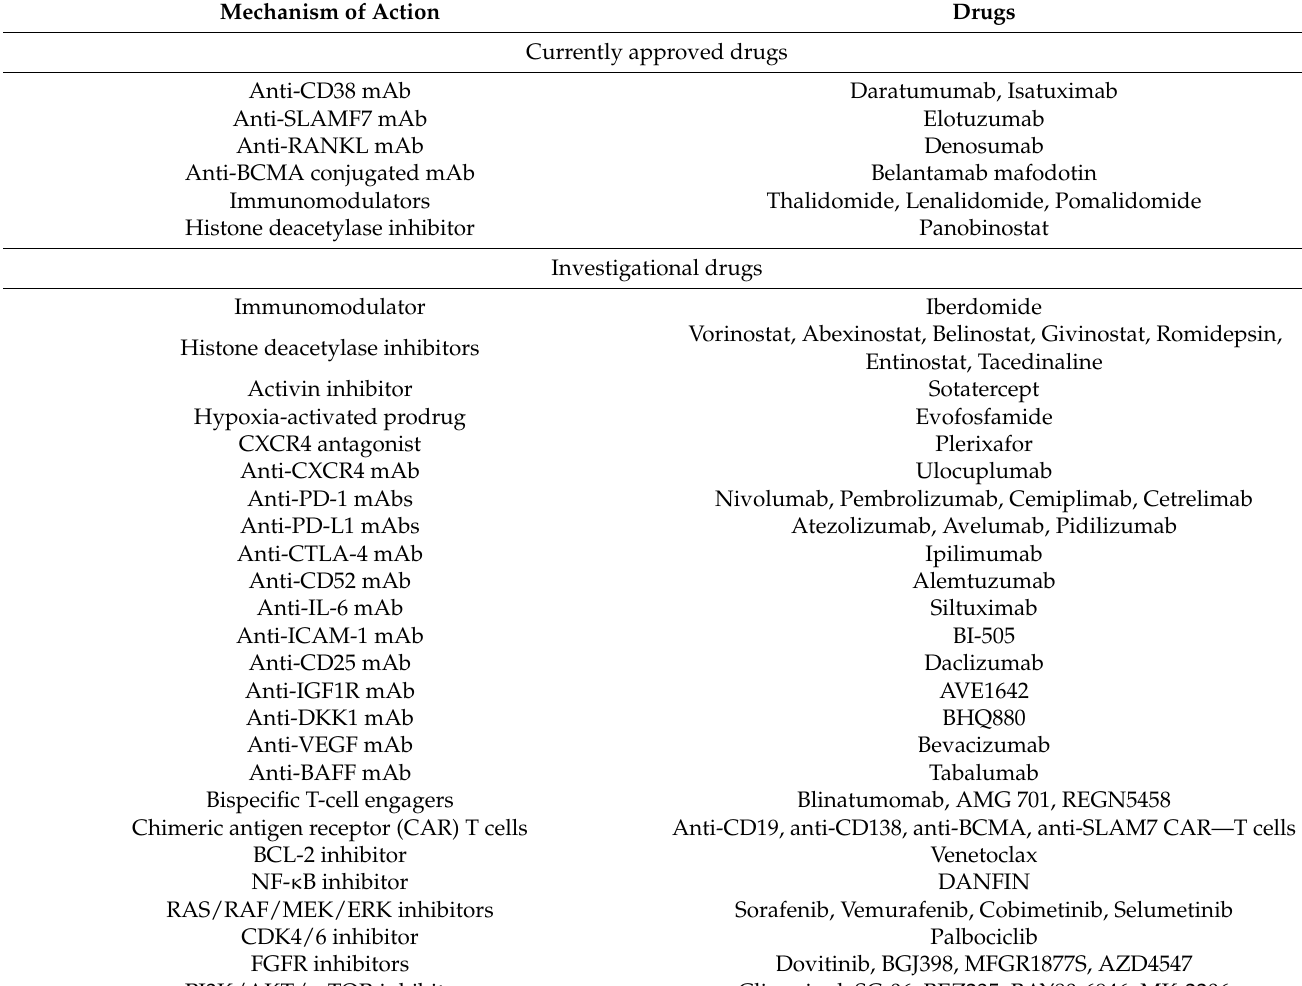
Table 1. Current and investigational treatment approaches targeting BMM in